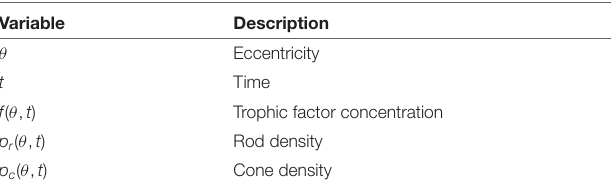
TABLE 1 | Variables employed in the non-dimensional mathematical model [Equations (1–5)].